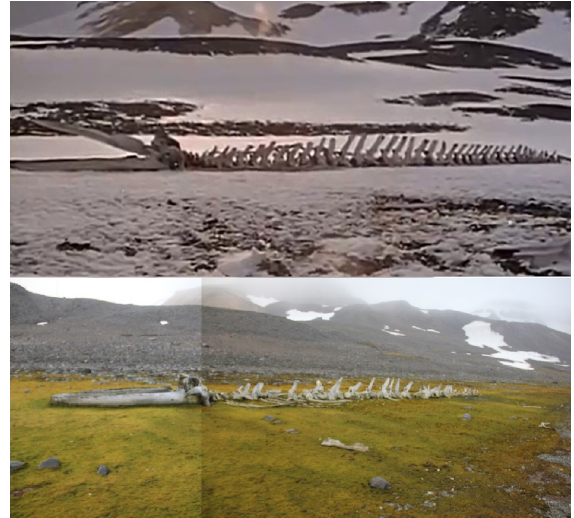
Figure 3. Original photo taken by the from Cousteau’s team showing the complete mounted whale skeleton in 1972 on a deep snow bank (above) and a recent (2014) aspect of the whale bones.